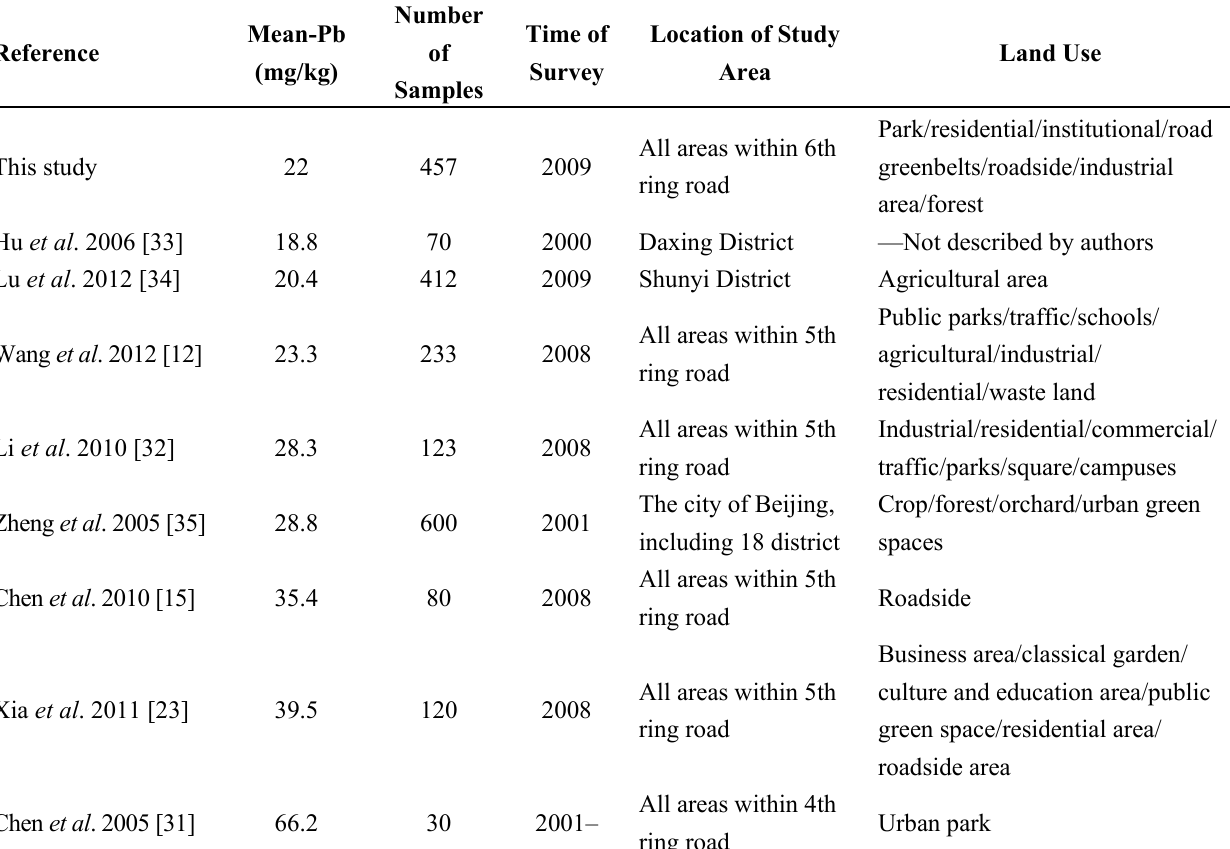
Table 4. Soil Pb levels according to different studies in